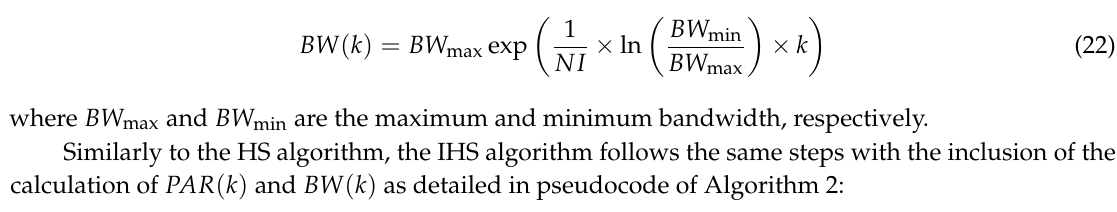
Algorithm 2: Improved Harmony Search Algorithm